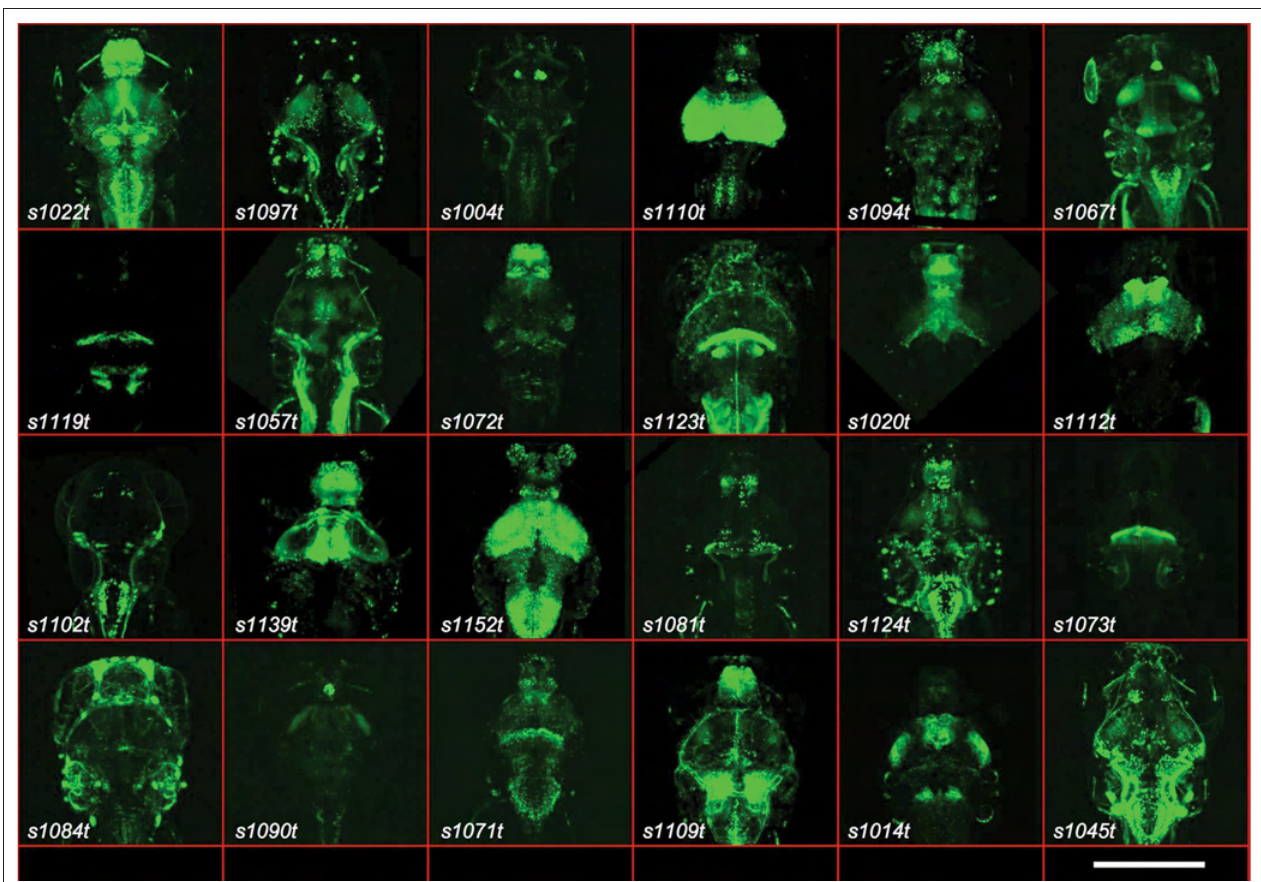
FiGUrE  | Gal4 expression patterns from the ET screen. Twenty-four examples are shown of expression patterns from the ET screen, with the line number indicated. All are dorsal images of 5- or 6-dpf larvae. The scale bar (bottom right) indicates roughly 200 μm. All larvae carry the indicated Gal4 insertion and UAS:Kaede